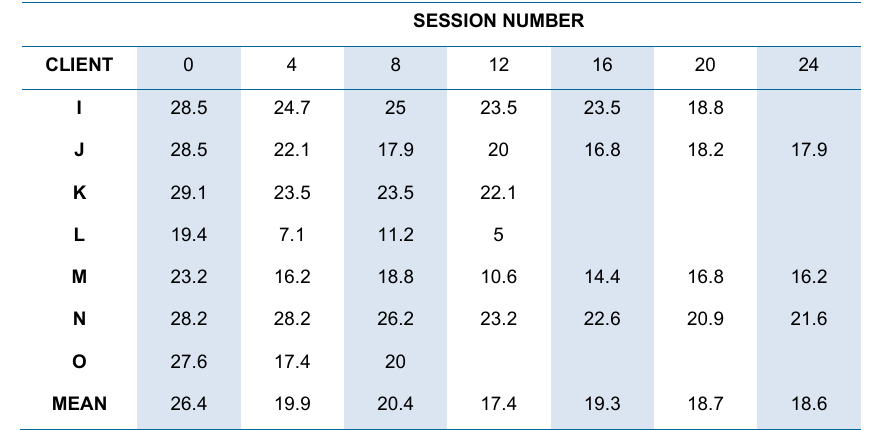
Table 7: Mean Clinical Core-OM score: 7 short-term clients